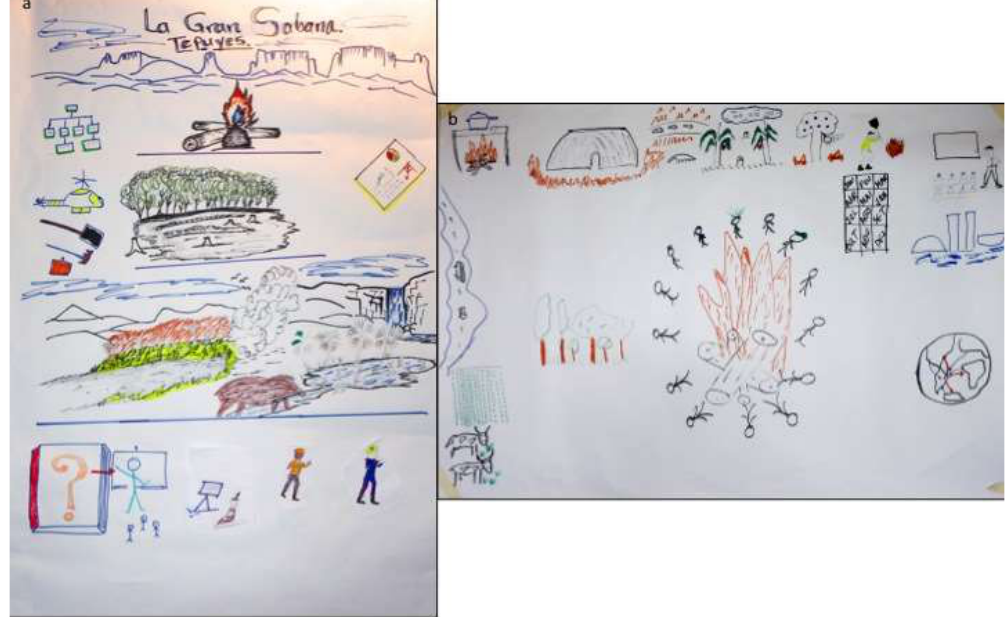
Figure 5. Rich picture made by the institutional groups: ( a ) Venezuela’s group included INPARQUES firefighters and national park rangers, CORPOELEC-EDELCA PCIV firefighters and the coordinator, and the Parupa Scientific Station Director. ( b ) The Brazilian group comprised members of the Instituto Socioambiental Brasil (ISA), Centro Nacional de Prevenc ̧ ão e Combate aos Ince ̂ ndios (Prevfogo-IBAMA), Instituto Nacional de Pesquisa da Amazo ̂ nia (INPA-Roraima), and Fundac ̧ ão Nacional do Indio (FUNAI).